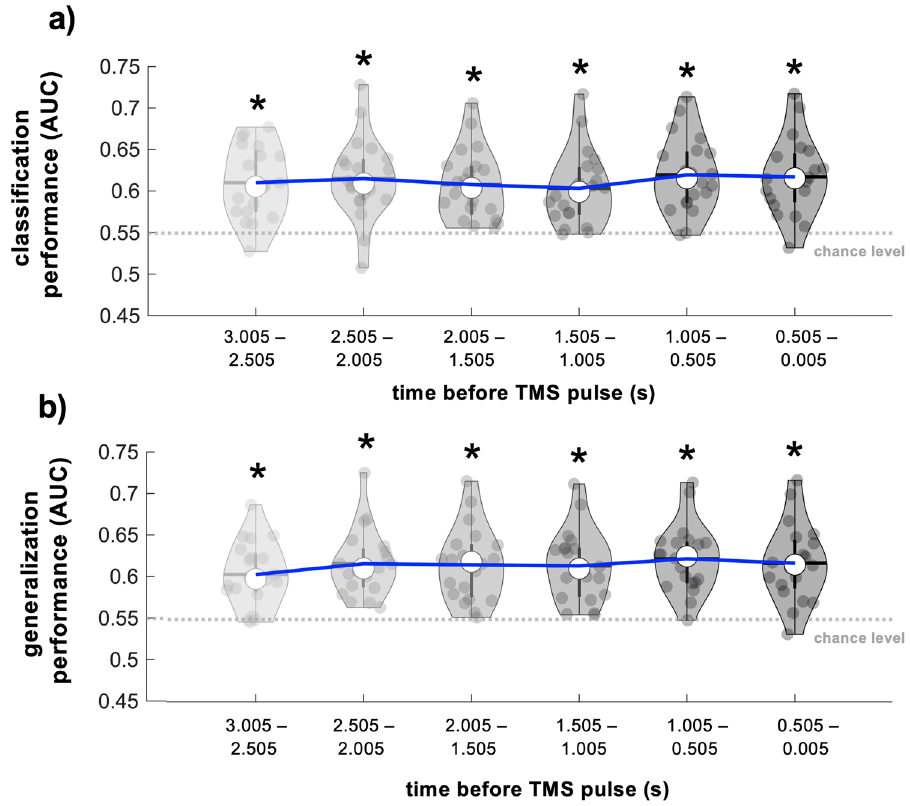
Figure 5. Evaluation of personalized classification performance over time. ( a ) AUC values reflecting performance of classifiers trained and tested using power spectral features obtained from EEG data in different time windows preceding TMS delivery. Classification AUC values for the time window closest to TMS delivery (0.500–0.005 s before TMS) did not differ from classification AUC values obtained for all other time windows. ( b ) AUC values reflecting the extent to which personalized classifiers trained using power spectral features obtained from EEG data immediately before TMS delivery (0.500–0.005 s, far right) generalized to earlier time windows. Classification AUC values for the time window closest to TMS delivery (0.500–0.005 s before TMS) did not differ from generalization AUC values for all other time windows. Note that for both panels, the data depicted on the right-most violin plot reflects the same classification AUC values depicted in Fig. 2a. Time windows used to calculate power spectral features are depicted on the x axes. Blue lines indicate group-level AUC values approaching TMS delivery. Grey dots represent individual participant AUC values, thick whisker represents interquartile range, thin whisker represents full range, white dot represents the group median and grey/black horizontal lines represent the group mean. The grey dashed lines indicate the empirical chance level. * Indicates statistical significance of AUC values when compared to empirical